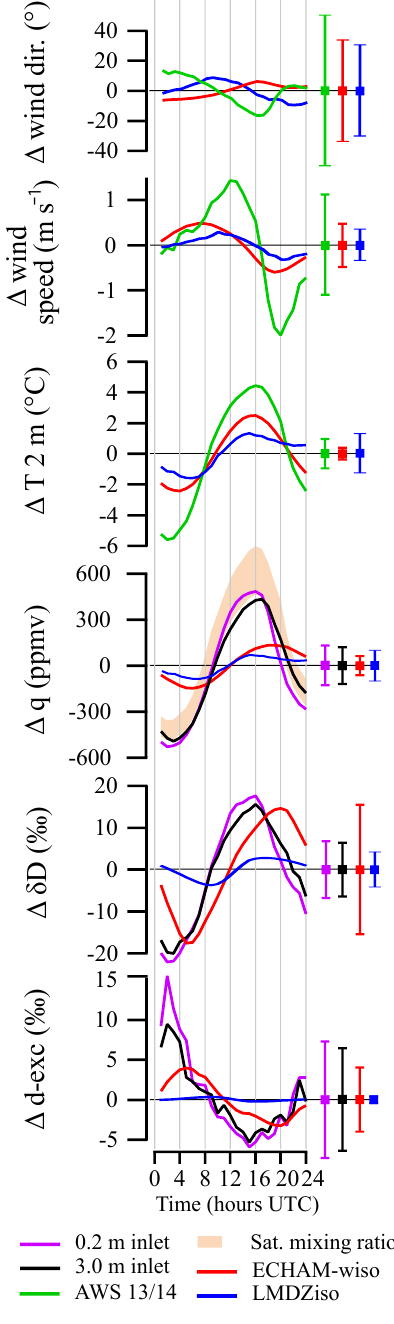
Figure 3. Stack of 18 diurnal cycles of the wind direction and wind speed (simulated at 10m for the models, measured at 2m for the observations), air temperature at 2m (measured with the AWS from the 2013/2014 season), humidity mixing ratio q , saturated mix- ing ratio range calculated with the surface pressure and tempera- ture at 2m ± 1 ◦ C, deuterium δ D and d-excess. Error bars represent ± 1MSD (mean standard deviation): average of the 24SD associ- ated with the hourly mean